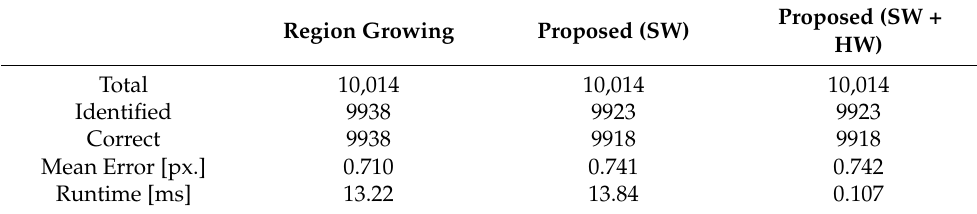
Table 4. Comparison of centroid algorithms, with FOV = 8°.